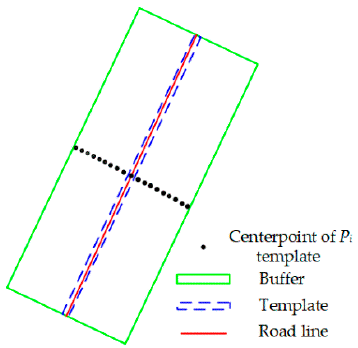
Figure 7. Statistical region construction.